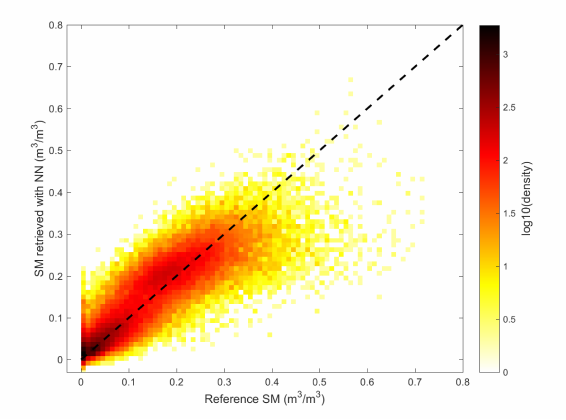
Figure 4. Scatter plot of the AMSR-E SM retrieved with the neural network (Model 15 in Table 3) versus SMOS L3 SM. The scatter plot is represented as the density of points in a logarithmic